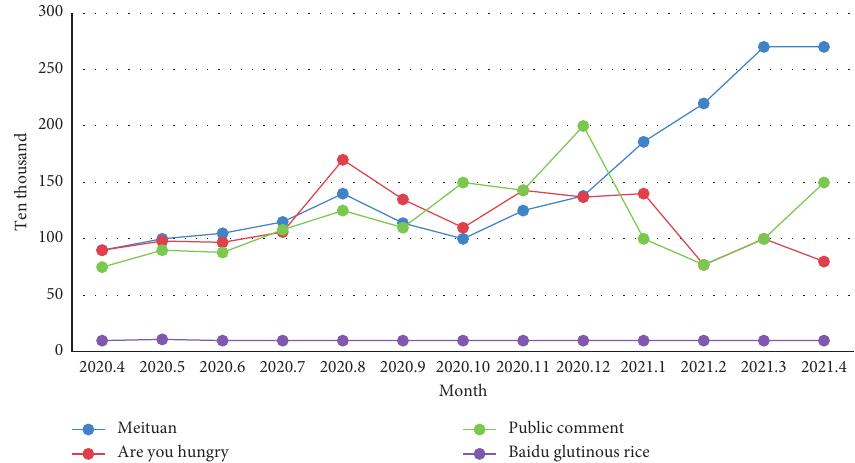
Figure 12: Distribution information of tourism platform for catering and gourmet